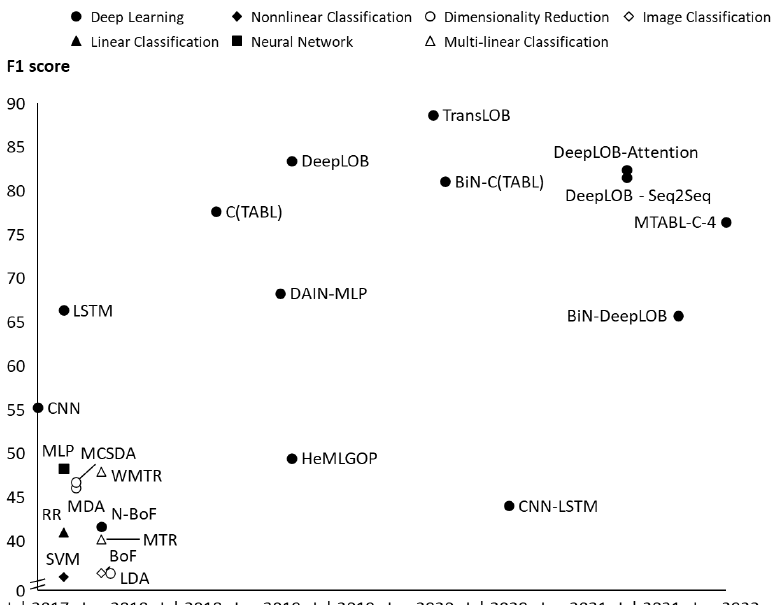
Figure 4. F1 score evolution over time for the state-of-the-art stock price prediction models trained on the benchmark LOB